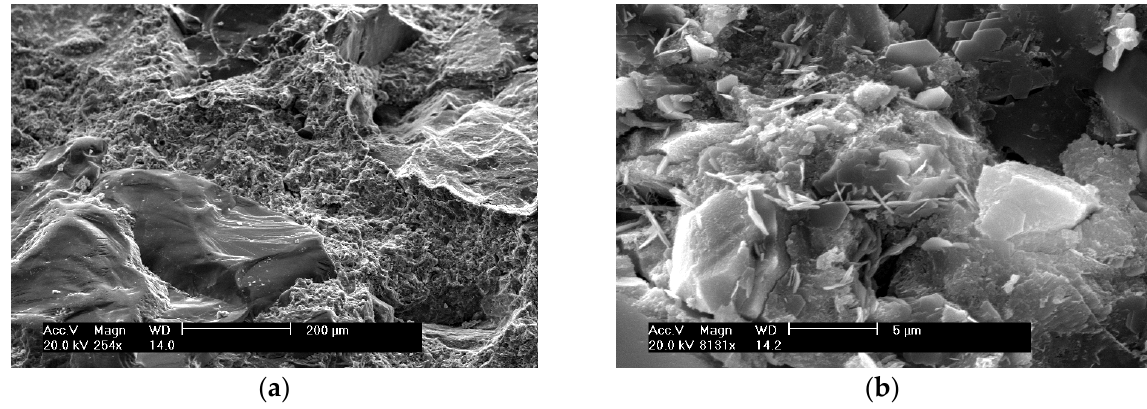
Figure 5. SEM of control concrete: ( a ) with magnification of ×254; ( b ) with magnification of ×8131.